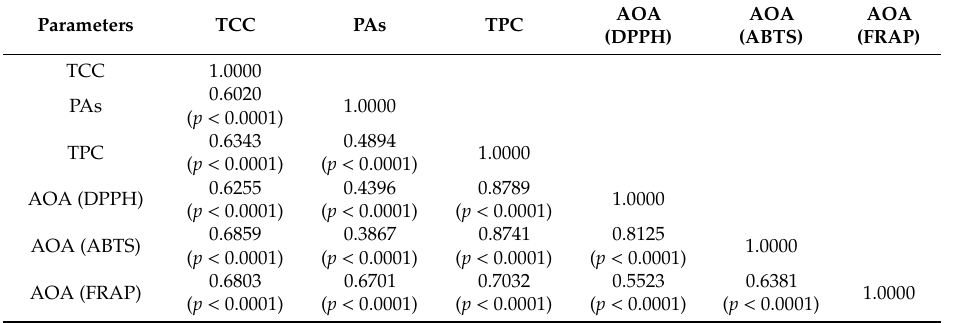
Table 2. Correlation matrix with the Pearson coe ffi cient values for the phenolic compounds and antioxidant activity of sorrel